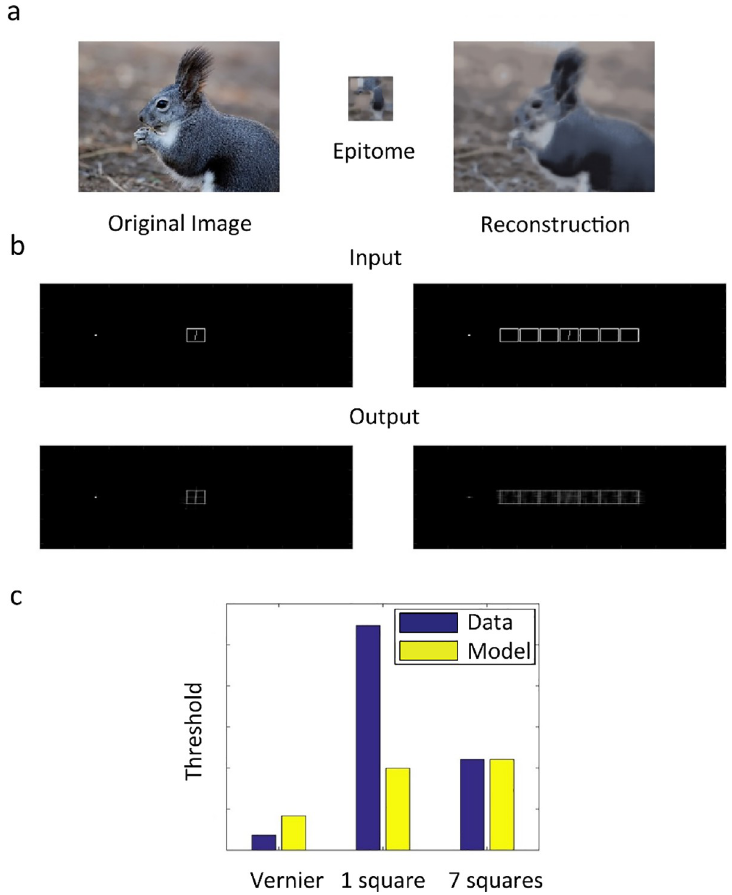
Fig 5. Epitomes. a. Illustration of the epitome model. An image (left) is compressed into an epitome (center), a summary of local features. The image on the right is reconstructed from the epitome. b. As an example for the classic texture evaluation, we show the stimulus and reconstructed image for the 1- and 7-square conditions. Human vernier offset thresholds are better for the 1-square than the 7-square condition. The model does not produce uncrowding because vernier offset direction in the output is not easier to make out in the 7-square than in the 1-square case (according to the authors’ judgment). c. Example for our performance measure. Human and model thresholds (see main text for how model threshold was computed) for vernier alone, single square and 7 squares conditions. The 7-square threshold is higher than the 1- square threshold, in contrast with human performance. Note: the model outputs a number quantifying how different the left and right vernier offset versions of the input are (so the higher this difference, the better the performance). To make comparison with the human threshold easier, we applied the following monotonic transformation to the output: “threshold-like output” = 1/“raw output”. Then, we scaled the result to be in the same range as the human results. This monotonic re-scaling cannot change the conclusions because monotonic outputs are mapped on monotonic performance and the same is true for U-shaped functions (see